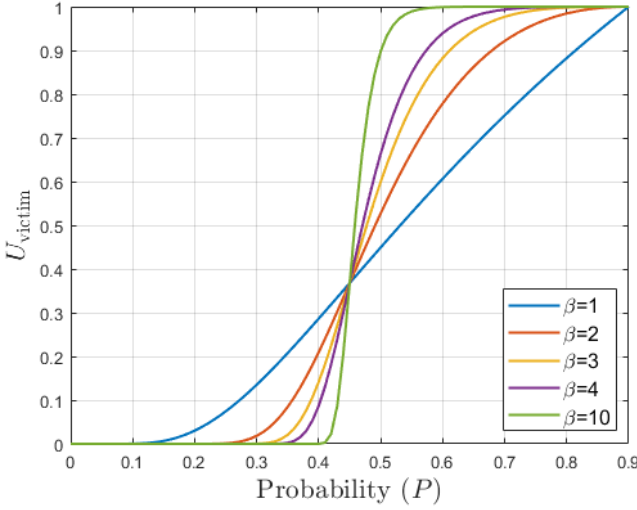
Figure 9. Impact of the β parameter on the selectivity of U victim function where P MAX =